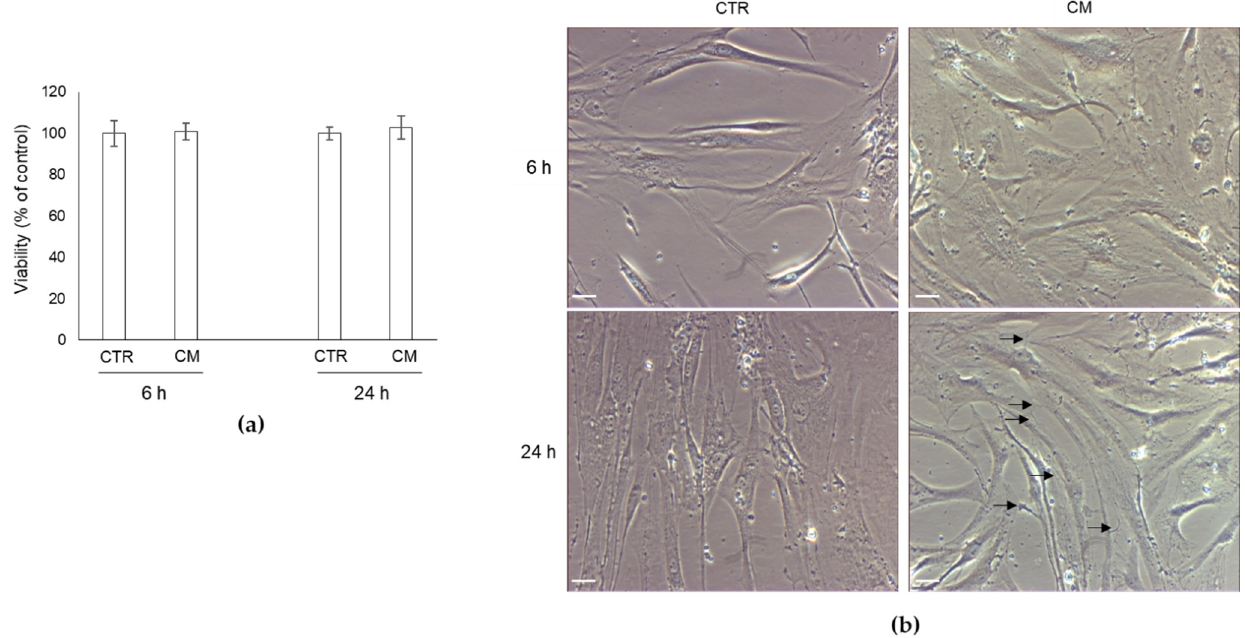
Figure 2. Effect of conditioned medium (CM) from PC3 bone metastasis-derived prostate cancer (PCa) cells on human primary osteoblasts (OB) viability and morphology. ( a ) cell viability measured by MTT assay and ( b ) cell morphology by means of light microscopy were evaluated in OB exposed for 6 and 24 h to CM from PC3 cells. Control cells (CTR) are represented by OB cultured for the same period of time in their specific growth medium. The histogram indicates the mean ± SD of three different cultures, and each was tested in duplicate. Scale bar = 30 μ m. Arrows indicate filopodium-like protrusions.